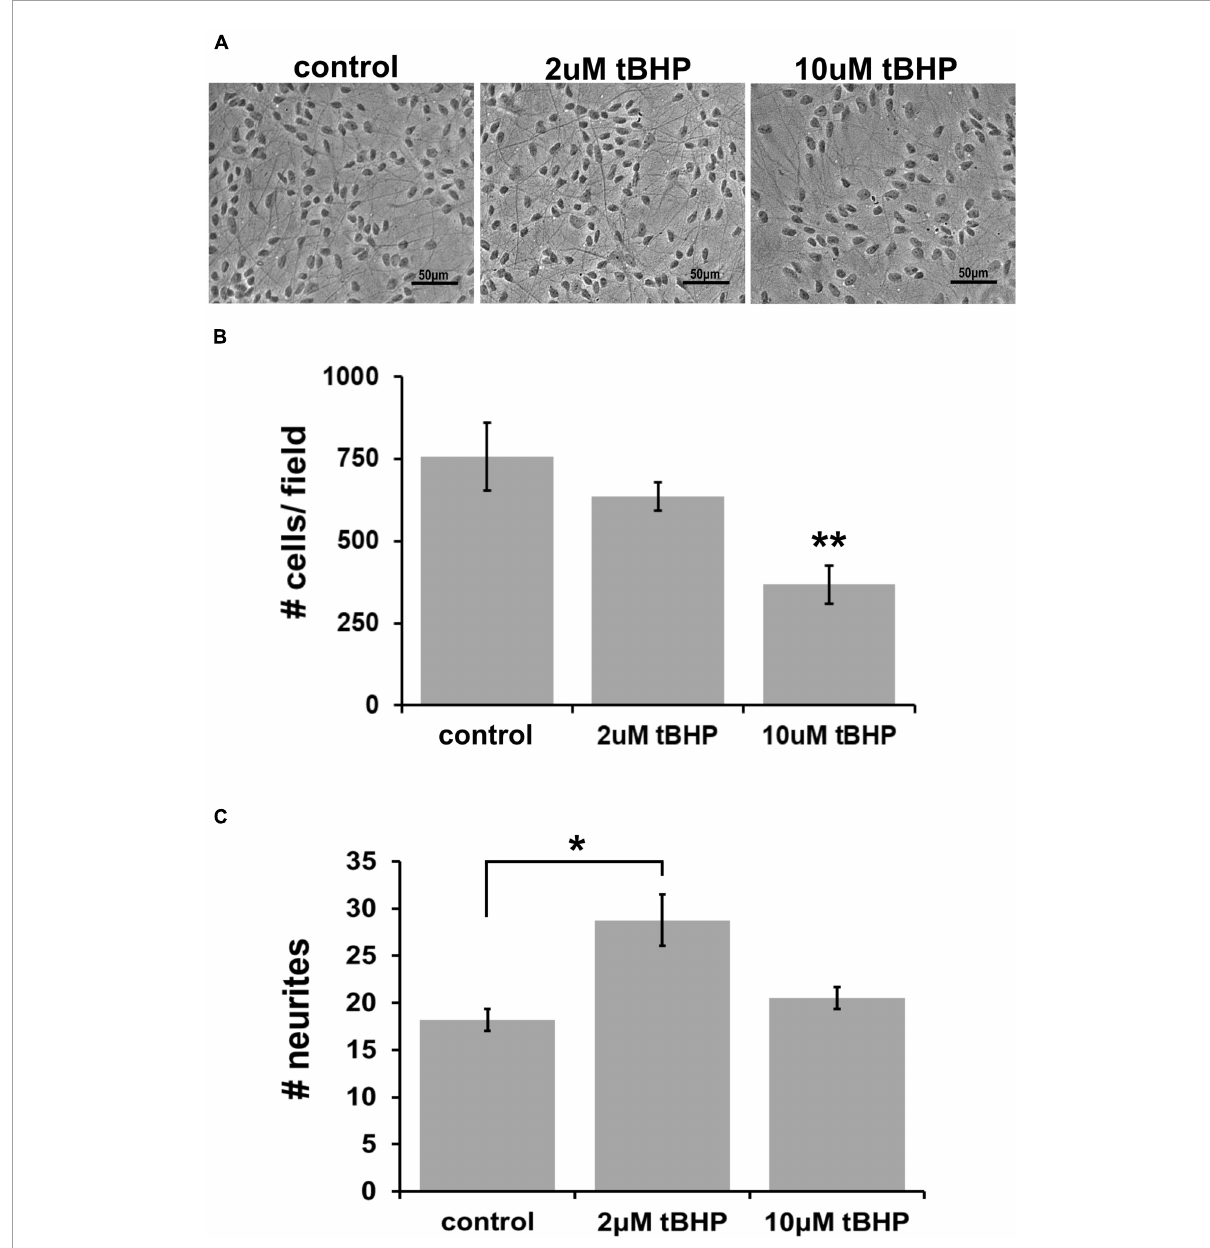
FIGURE1 Establishing the optimal parameters for oxidative stress in ReN cells. (A) Phase contrast image showing differentiated ReN cells under control conditions (cont) or exposure to 2 µ M or 10 µ M tert-butylhydroperoxide (tBHP). Note that there is a reduction in the number of cells when exposed to 10 µ M tBHP (right panel). Magnification is 200 × , scalebar is 50 µ M. (B) Manual cell counts from phase contrast images reveal that 2 µ M tBHP led to a 16% reduction while 10 µ M tBHP led to a 52% reduction in the number of cells. (C) Measurement of the number of neurites along an intersecting line from the top of the field to the bottom of the field while avoiding soma reveals that 2 µ M tBHP led to a 45% increase in neurite density while 10 µ M tBHP had no effect on neurite density. Images were converted to binary (black and white) and lines were drawn from the top to the bottom of the field. The number of times the intensity went from 255 to 0 (encounter with a neurite) was counted and recorded to determine the number of neurites. Neurites from > 10 cells (between 10 and 20 cells) were analyzed and three samples, each with six trials, were measured to determine neurite number. * p ≤ 0.05, ** p ≤